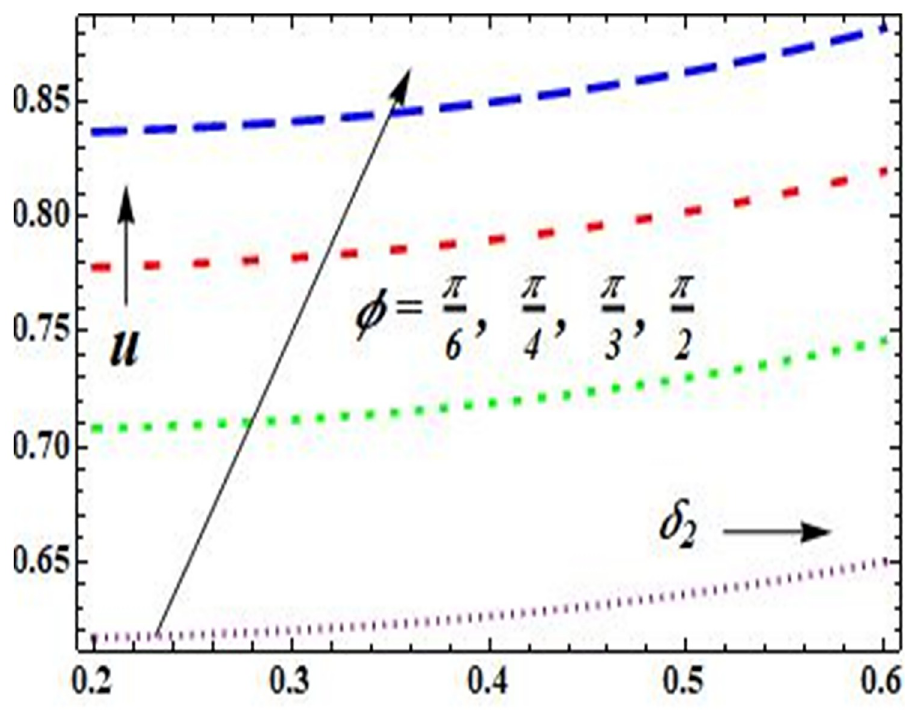
Fig 23. Plot of u on ϕ & δ 2 with M = 2.0, d 1 = 0.2, F = 0.3, d 2 = 0.6, L 2 = L 1 = 0.2, r = 0.2.